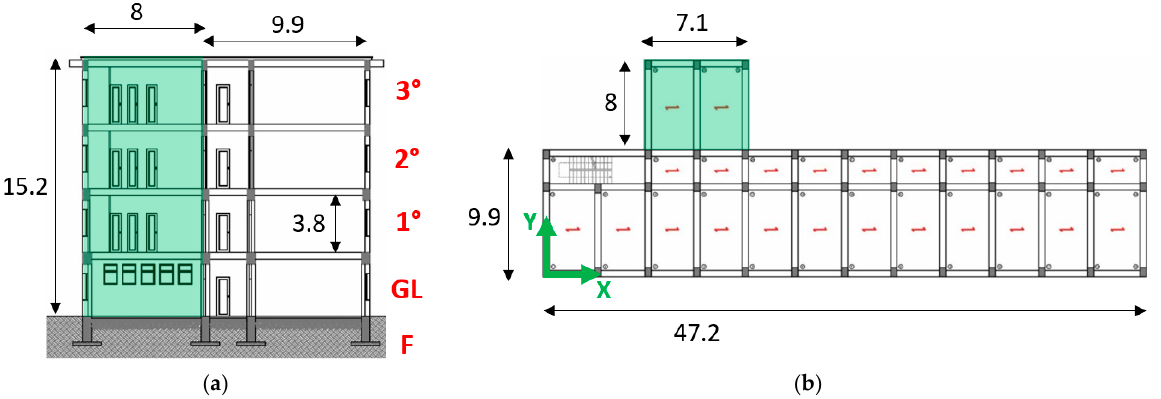
Figure 5. Frangipane School in Reggio Calabria: ( a ) vertical and ( b ) horizontal cross-sections (out-of-scale, with dimensions in m).